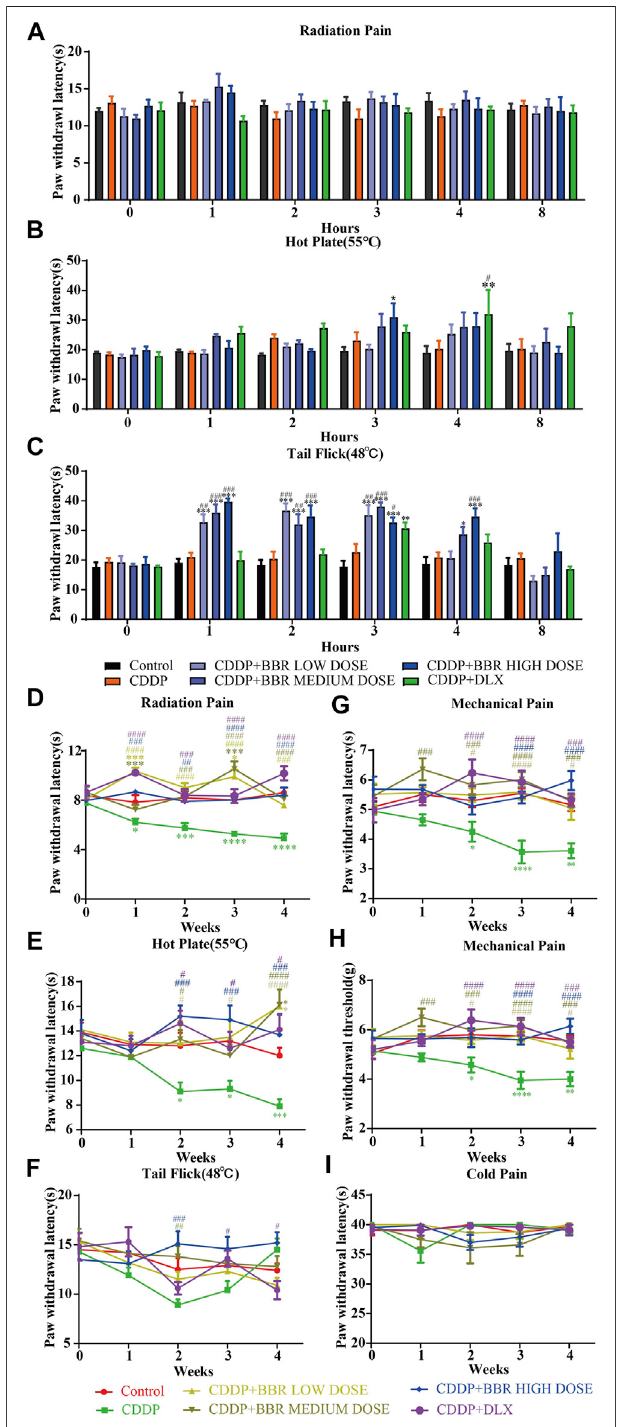
FIGURE 1 | BBR increased the pain threshold and inhibited thermal hyperalgesia induced by CDDP. (A) The latent period of paw withdrawal induced by light radio stimulation. (B) The paw withdrawal latency stimulated by 55 ° C hot plate. (C) Preventive administration of BBR increased the